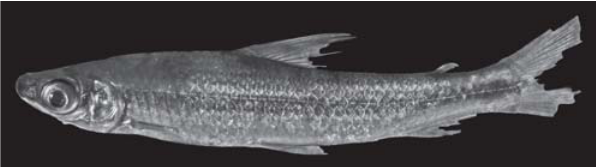
Fig. 14. Laemolyta garmani named “ Laemolyta garmani macra ”, MHNG 2197.38, 71.1 mm SL; Peru, río Marañon, Concordia, tributary of río Nucuray. Caudal fin damaged.